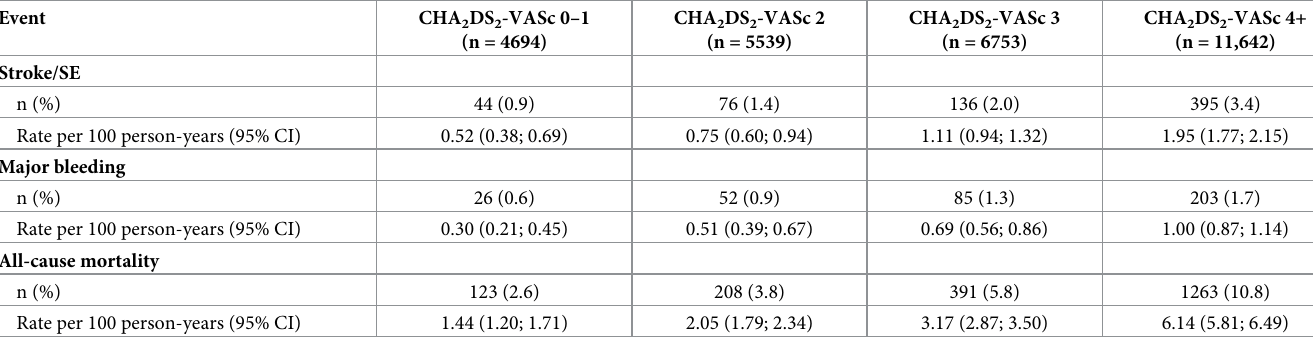
Table 6. Crude event rates during 2-year follow-up according to CHA 2 DS 2 -VASc